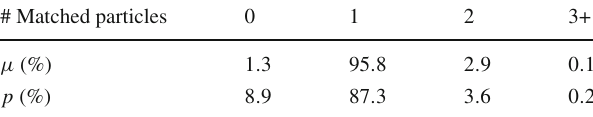
Table 1 Pattern-recognition performance for the target muon and pro- ton in simulated BNB CC ν μ quasi-elastic interactions. The total num- ber of events was 53,168 and 86.0% were deemed to have exactly one reconstructed particle matched to each